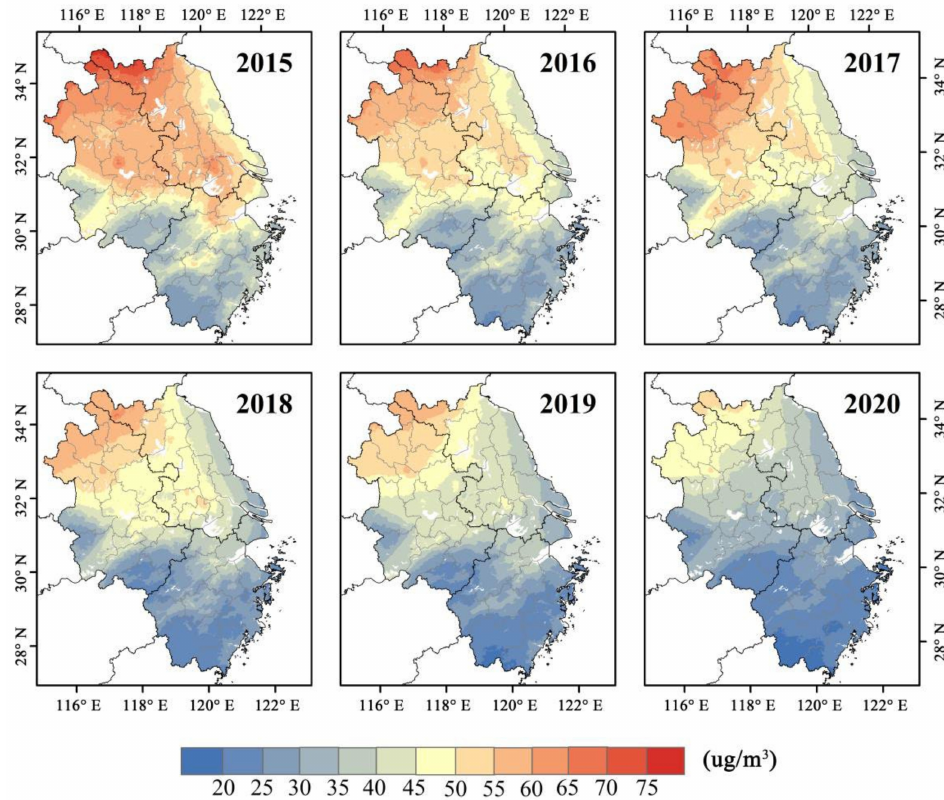
Figure 4. Spatial distributions of annual PM 2.5 concentrations in the YRD from 2015 to 2020.